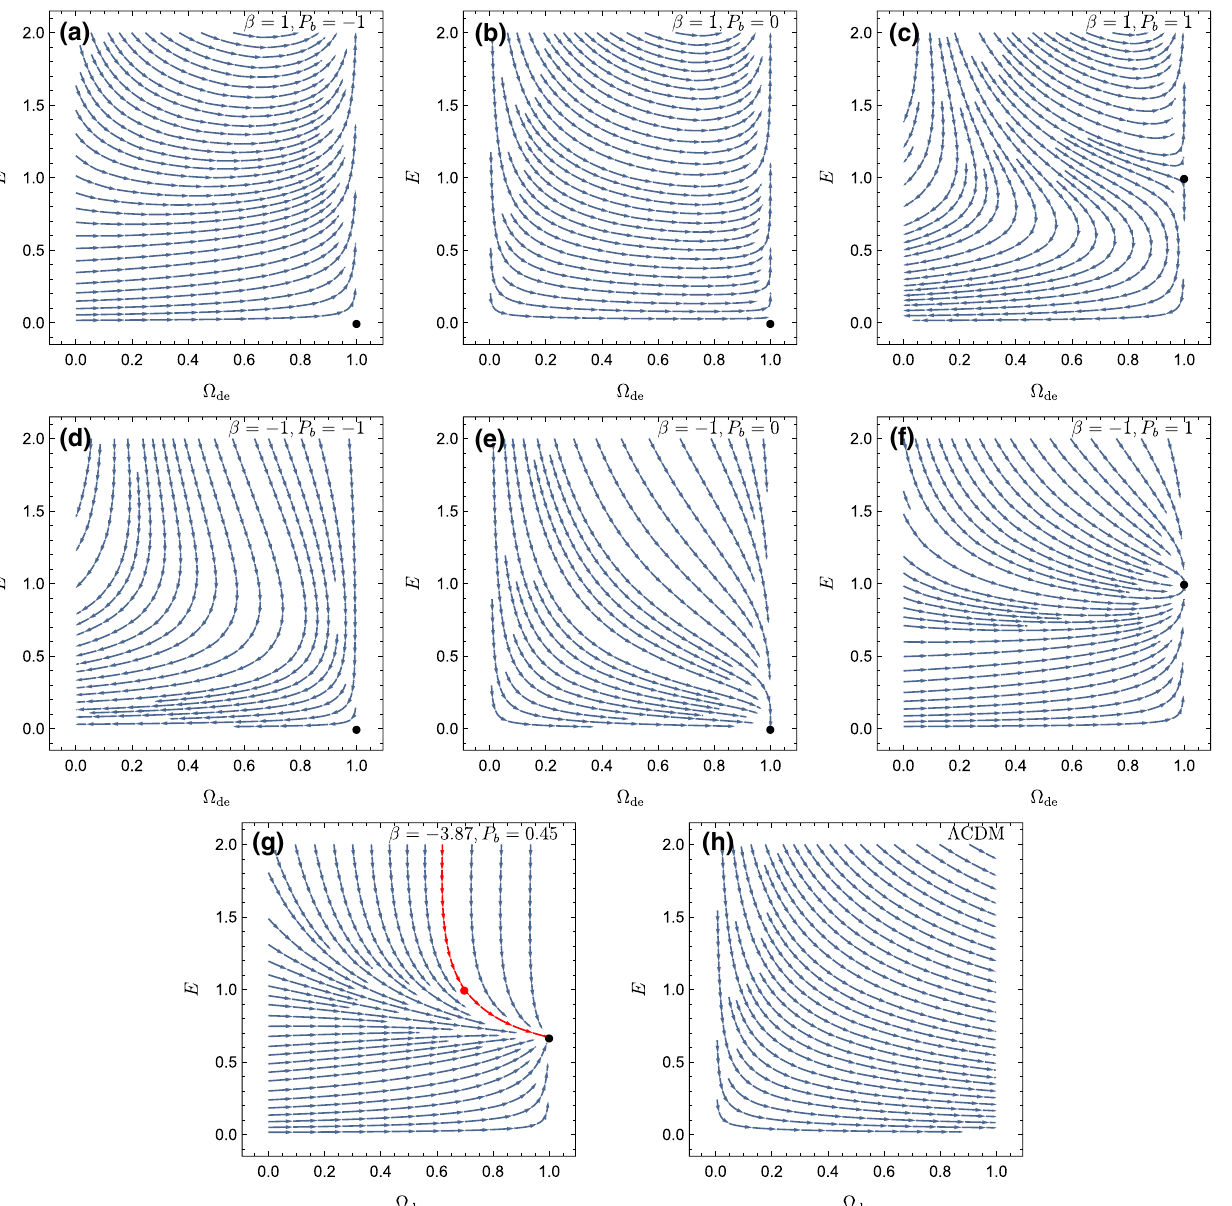
Fig. 3 The dynamic system evolution of the GP parameterization. a – f The evolution of the dynamics system for β = − 1, 1 and P b = − 1, 0, 1. g The situation of β = − 3 . 87 and P b = 0 . 45, the red line displays the evolution under the best-fit values listed in Table 3 and the red dot